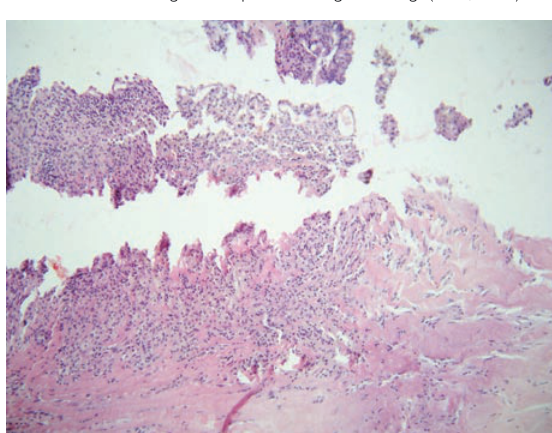
Figure 5. The wall of the mucocele consisted of granulation tissue (with foamy histiocytes and neutrophils) and condensed collagen. An epithelial lining is lacking. (H&E,